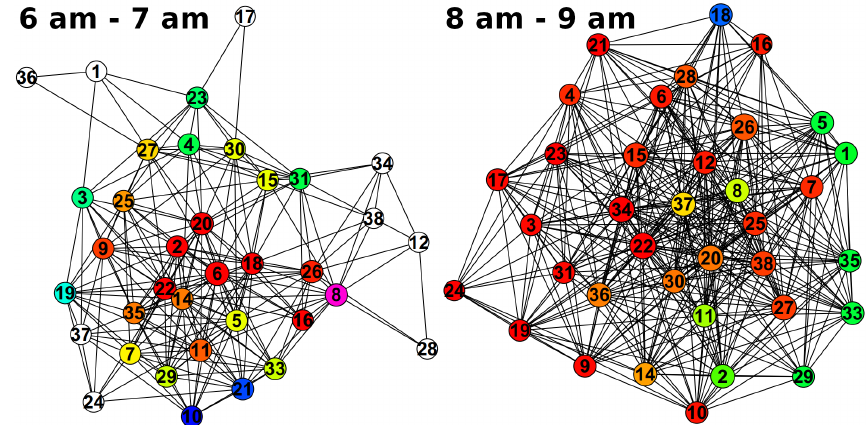
Figure 4. Graph plots of two hourly networks both representing contacts between horses on the 3rd of June 2018. The nodes represent the horses and the edges represent undirected contacts between them within the given hour. Different cliques are coloured differently, whilst nodes belonging to more than one clique are coloured only with regard to the larger clique. White nodes do not belong to any